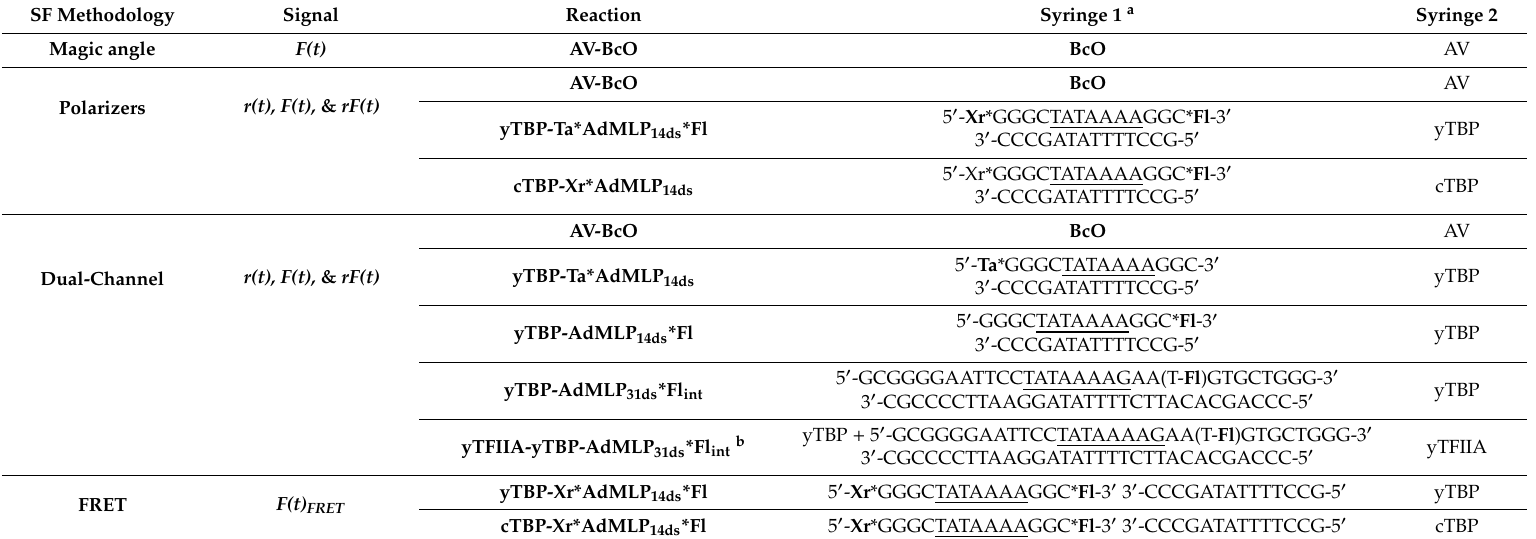
Table 1. Stopped-flow association reactions monitored by F(t) , r(t) , rF(t), and F(t) FRET sensing